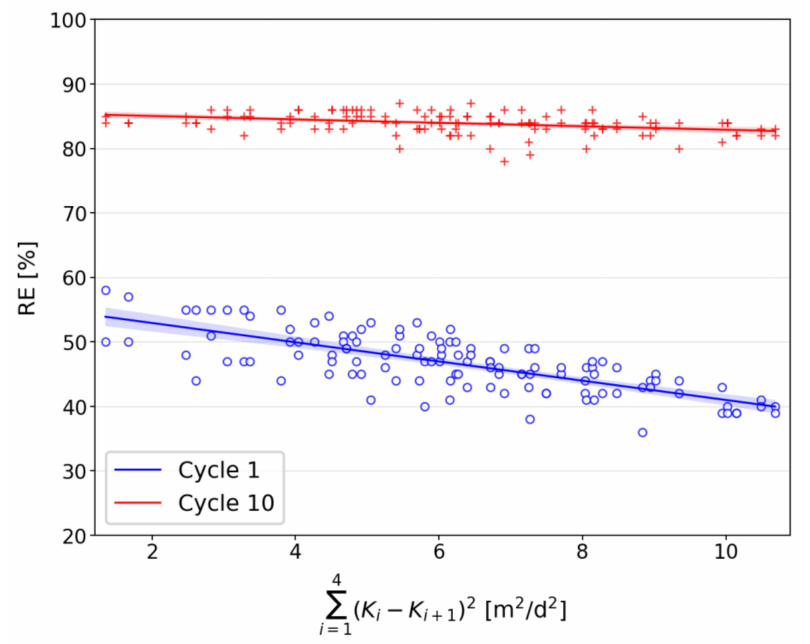
Figure 9. Distributions of the RE values versus the sum of squared hydraulic conductivity difference between neighboring layers for the first (blue circles) and tenth (red crosses) ASR cycles. The straight lines are obtained by the first-order linear regression with 95%